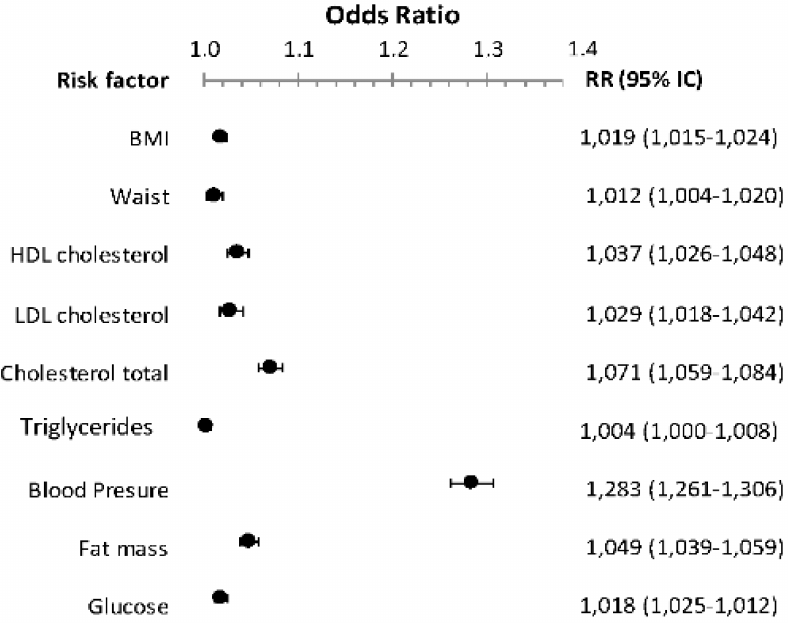
Figure 3. Relative Risk (RR) of patients who had worsened cardiovascular risk factors in the 2019–2020 season when compared with the 2018–2019 season. Patients were considered to have worsened when they changed to a worse category in the corresponding risk factor: BMI (normal, overweight, obesity); glycemic status (normal, prediabetes, diabetes); blood pressure status (normal, pre-AHT, AHT1, AHT2); waist (normal, high); fat mass (normal, high); total cholesterol (normal, high); LDL (normal, high, very high); HDL (normal, low); and TG (normal,